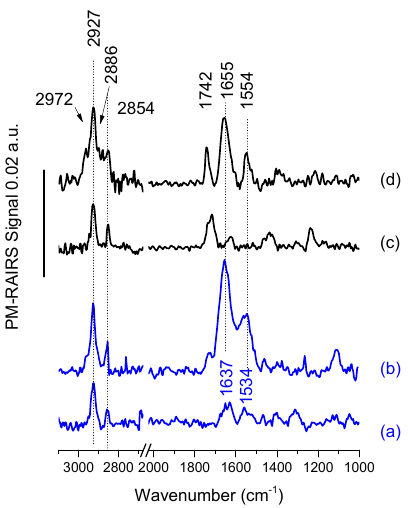
Figure 2. PM-RAIRS spectra of gold surfaces functionalized with ( a ) MUAM, ( b ) MUAM-[K 3 ]SHa-COOH, ( c ) MUA and ( d ) MUA-[K 3 ]SHa.